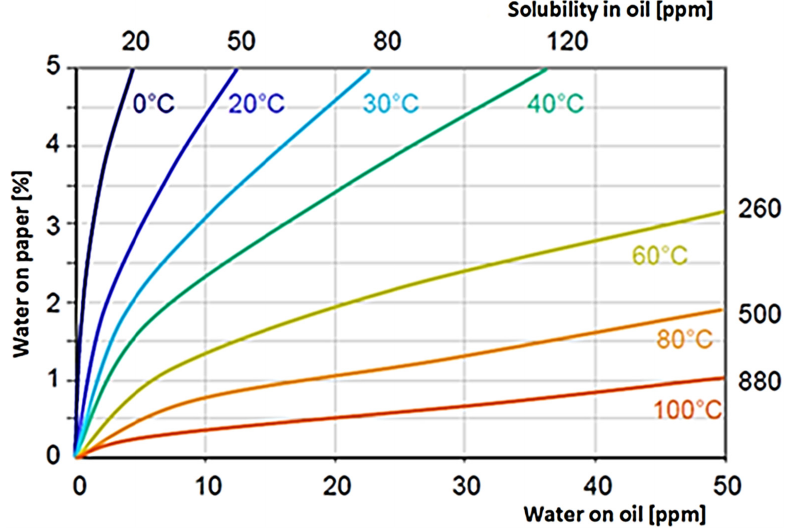
Figure 16. Oomen equilibrium curves, adapted from [54].